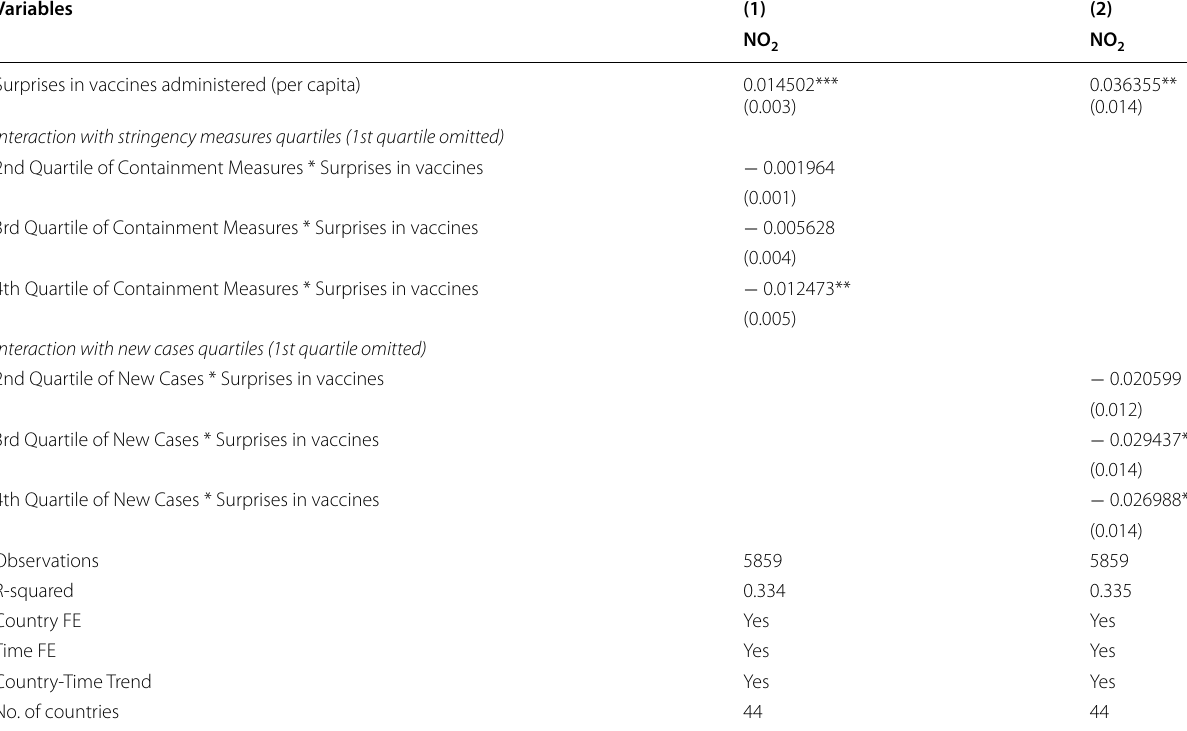
Table reports results for Eq. 3. The dependent variable is change in NO 2 per capita in columns 1 and 2 and change in retail and recreational mobility in columns 3 and 4. The forecast error in vaccine rollout is interacted with the stringency of containment measures (categorized into four quartiles) in column 1 and 3. The forecast error in vaccine rollout is interacted with the level of new cases (moving average over seven days and also categorized into four quartiles) in column 2 and 4. The variable are lagged one day. All regressions control for stringency of containment measures and other non-pharmaceutical interventions, lagged mobility and NO 2 per capita, country specific time trends, as well as country and time fixed effects. Standard errors are clustered at the country level. *** p < 0.01, ** p < 0.05, * p <